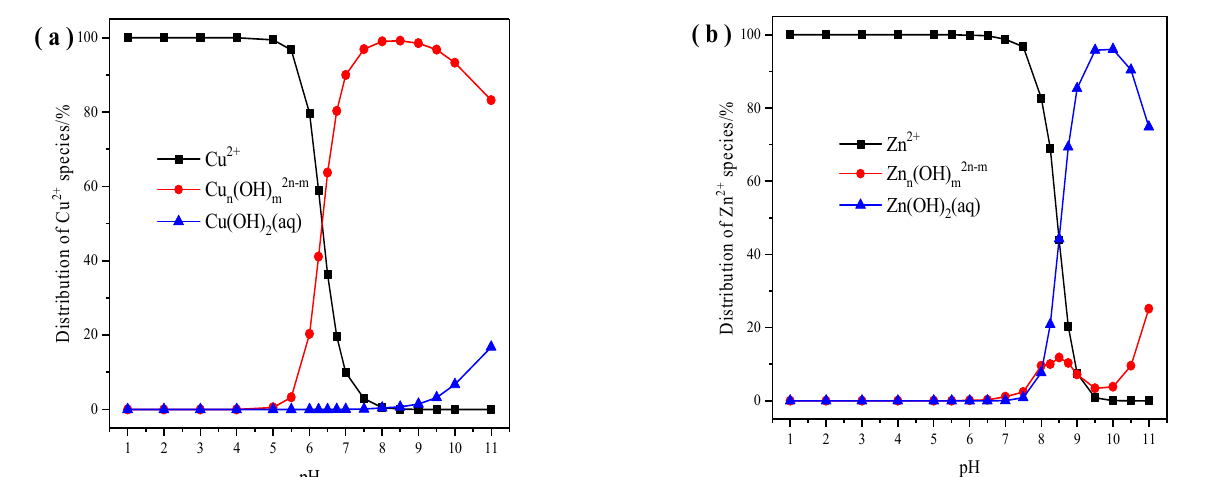
Figure 11. The state distribution of Cu 2+ ( a ) and Zn 2+ ( b ) at different pH values.